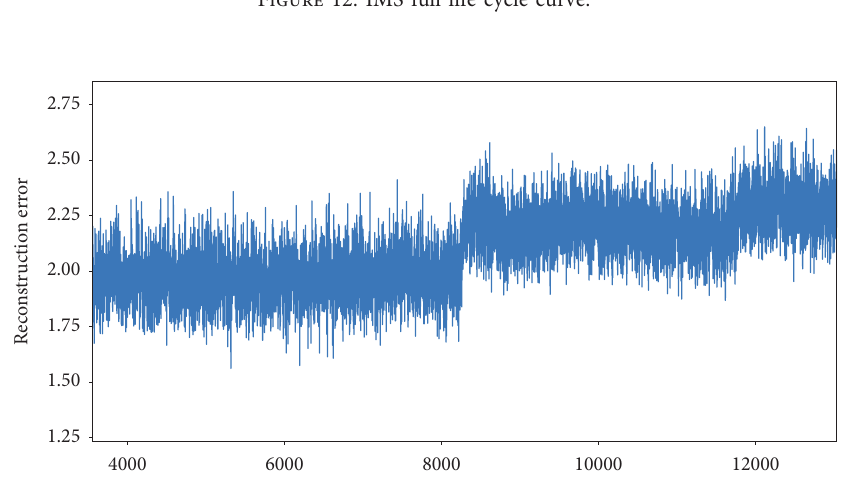
Figure 12: IMS full life cycle